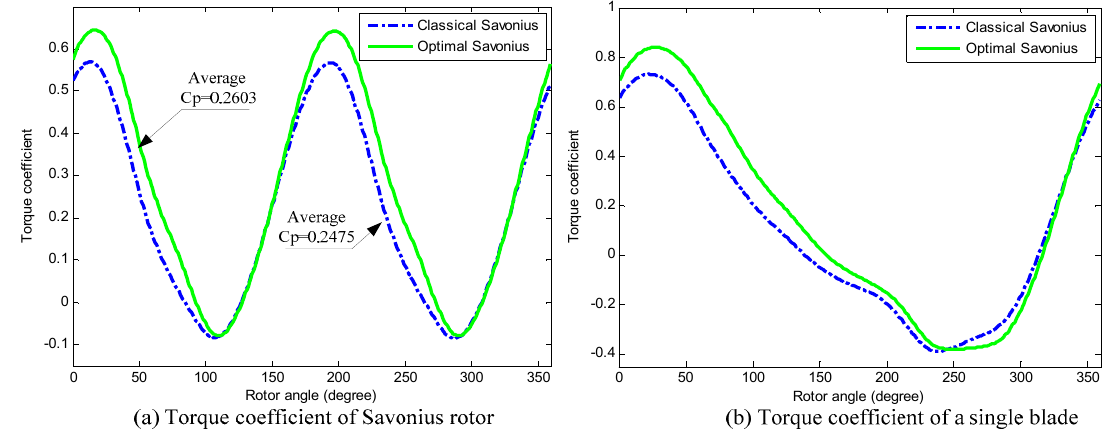
Figure 21. ( a ) Savonius rotor and ( b ) a single blade: comparison of the instantaneous C p .